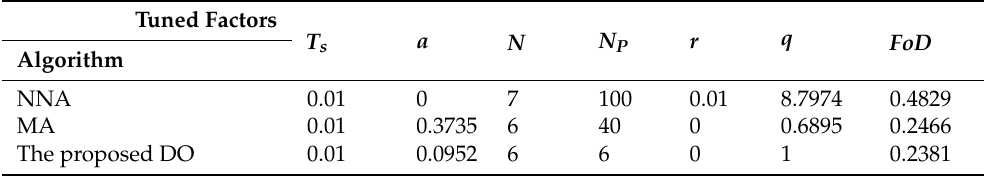
Figure 6. The convergence effort of the applied algorithms to tune the developed DTLF-MPC gains. Table 1. The tuned factors of the developed DTLF-MPC depending on the applied algorithms with the corresponding cost function FoD value.